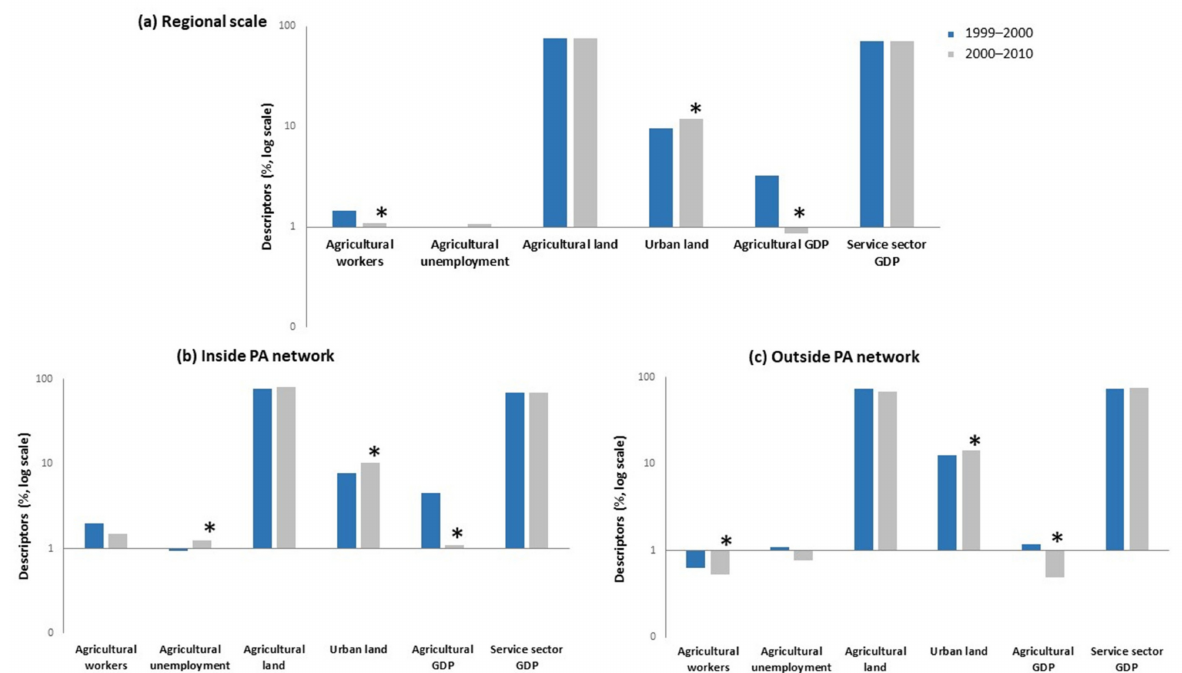
Figure 6. Temporal evolution of the socioeconomic descriptors of the local populations linked to HNVF ( a ) at a regional scale (study area); ( b ) inside of, and ( c ) outside of the PA boundaries. Statistically significant changes ( p < 0.05) analysed by means of Student’s t test are indicated with an asterisk.